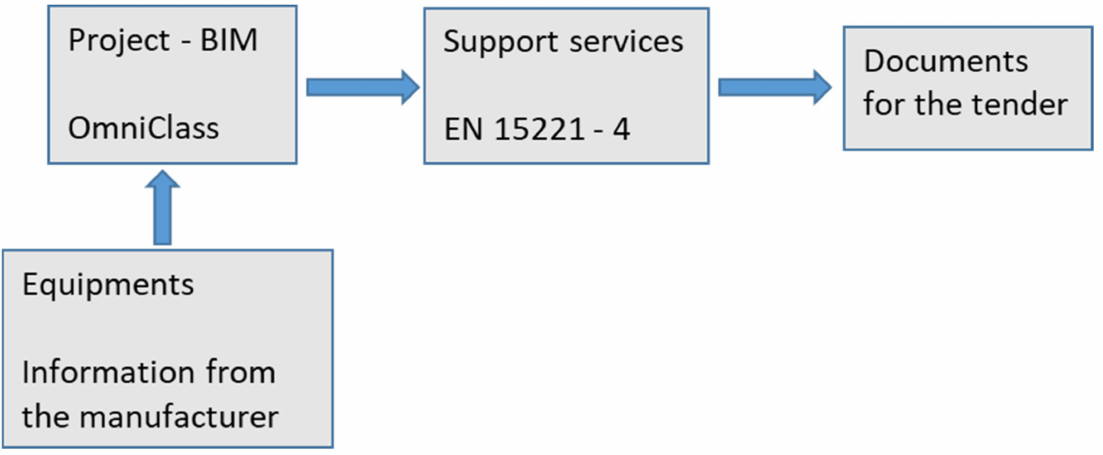
Figure 1. Diagram of the solution process. Source: